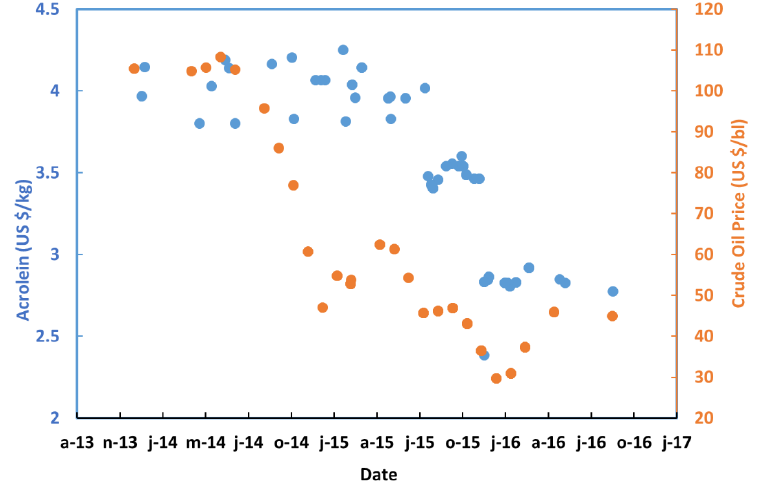
Figure 9. Small shipments acrolein prices [74] imported in India from China and crude oil price [75] trend between 2013 and 2016.